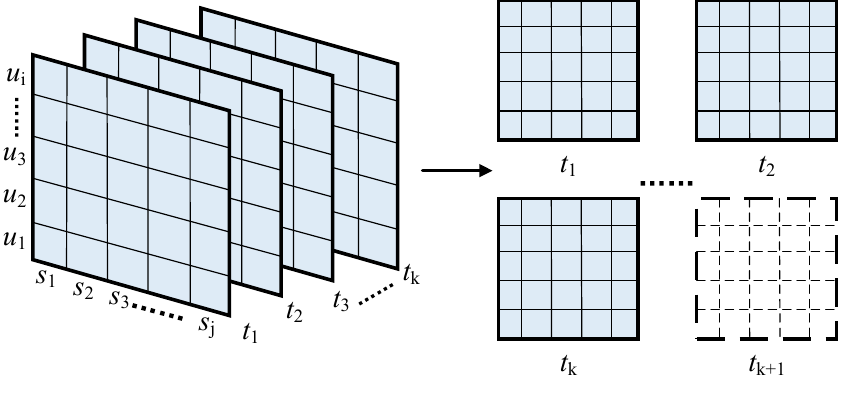
Figure 2. Users–service–time tensor.